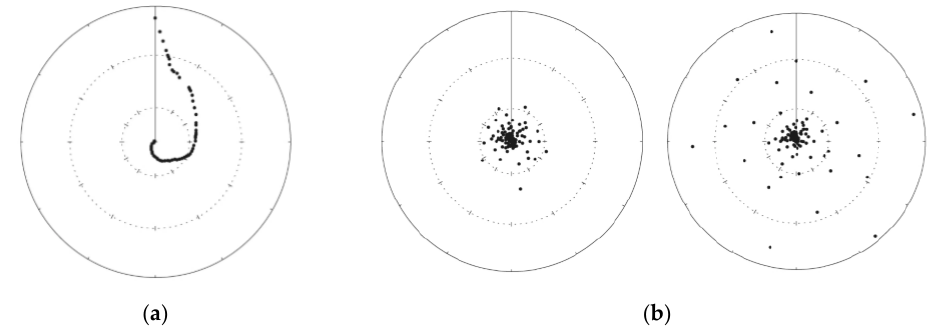
Figure 6. Same visual model representing the tax fraud phenomenon: every dot stands for a person (or a group of people) who evaded tax. The further away from the centre of the circle, the more taxes have been evaded: ( a ) On the left, the polar dot chart organises the dots from the highest to the lowest value of fraud. According to Bertin, creating a line is actually the best visual solution to make an image memorisable. However, the analogic relationship between the visualization and the phenomenon is rather weak and cryptic; ( b ) On the right, the two polar dot charts are still based on the same functioning-principle although they do not align the dots as the previous example did. They instead place the dots differently—depending on the degree of tax fraud—conveying either the idea of a united collective (centre), or of a more individualistic society (dots spread apart)